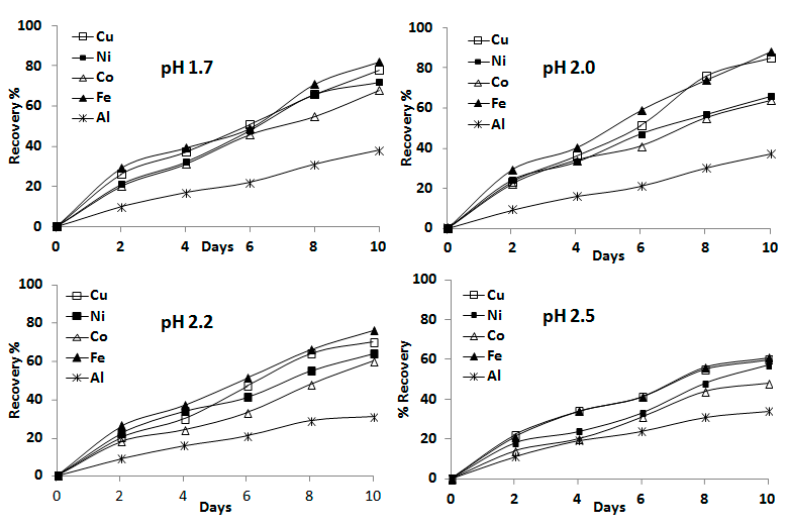
Figure 2. Metal recovery yields in various pH conditions during bacterial leaching of PCB at 2% PD, 308 K.